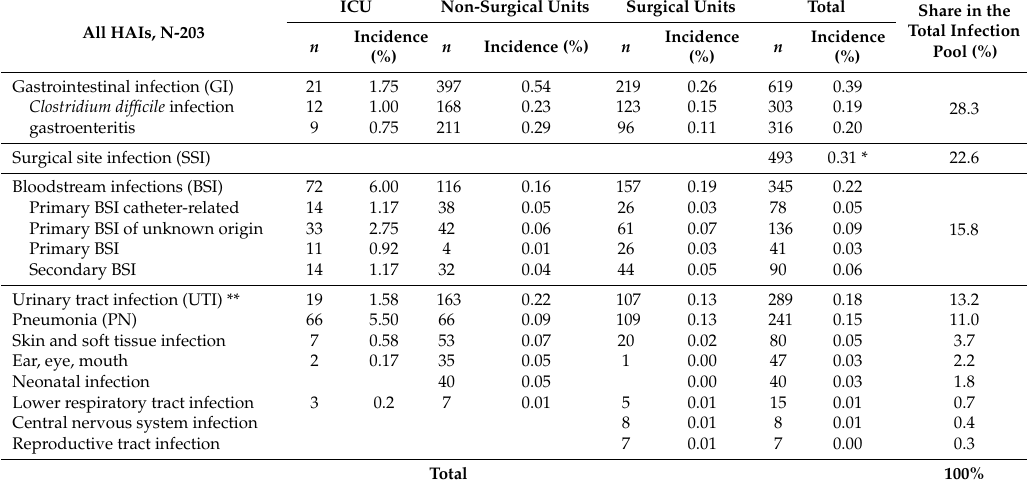
Table 2. Incidence of healthcare-associated infections (HAIs) by major and specific site of infection in 2012–2016. All HAIs,